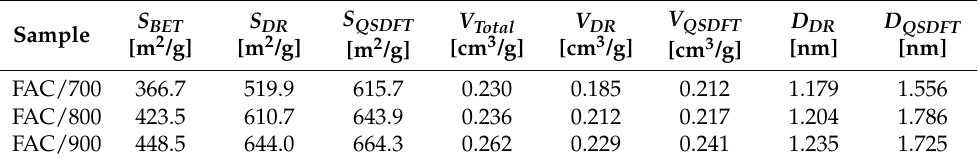
Table 2. Compilation of the results from the analysis of the activated carbons porous structure via the BET, DR, and QSDFT methods based on nitrogen adsorption isotherms; S BET is the specific surface area determined by the BET method, S DR is the specific surface area determined by the DR method, S QSDFT is the specific surface area determined by the QSDFT method, V Total is the total pores volume determined at a relative pressure P / P 0 = 0.98, V DR is the micropores volume determined by the DR method, V QSDFT is the micropores volume determined by the QSDFT method, D DR is the peak pore size determined by the DR method, and D QSDFT is the peak pore size determined by the QSDFT